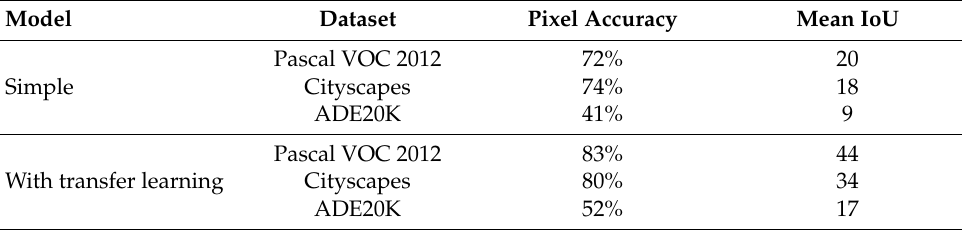
Table 6. Results of the architecture with increased resolution size on the three datasets.